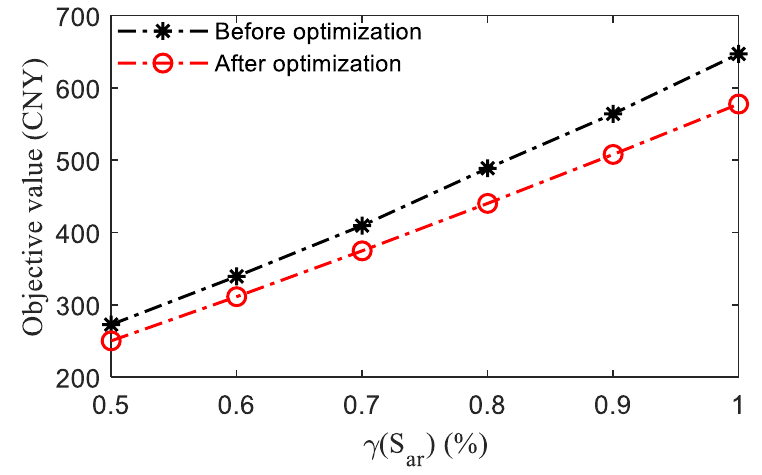
Figure 9. Comparison of objective value before and after optimization. It can be seen from Figure 9 that the object value after optimization was reduced by 9% compared with before optimization. For different sulfur content, the best calcium/sulfur molar ratio was obtained, and the calculation results are shown in Table